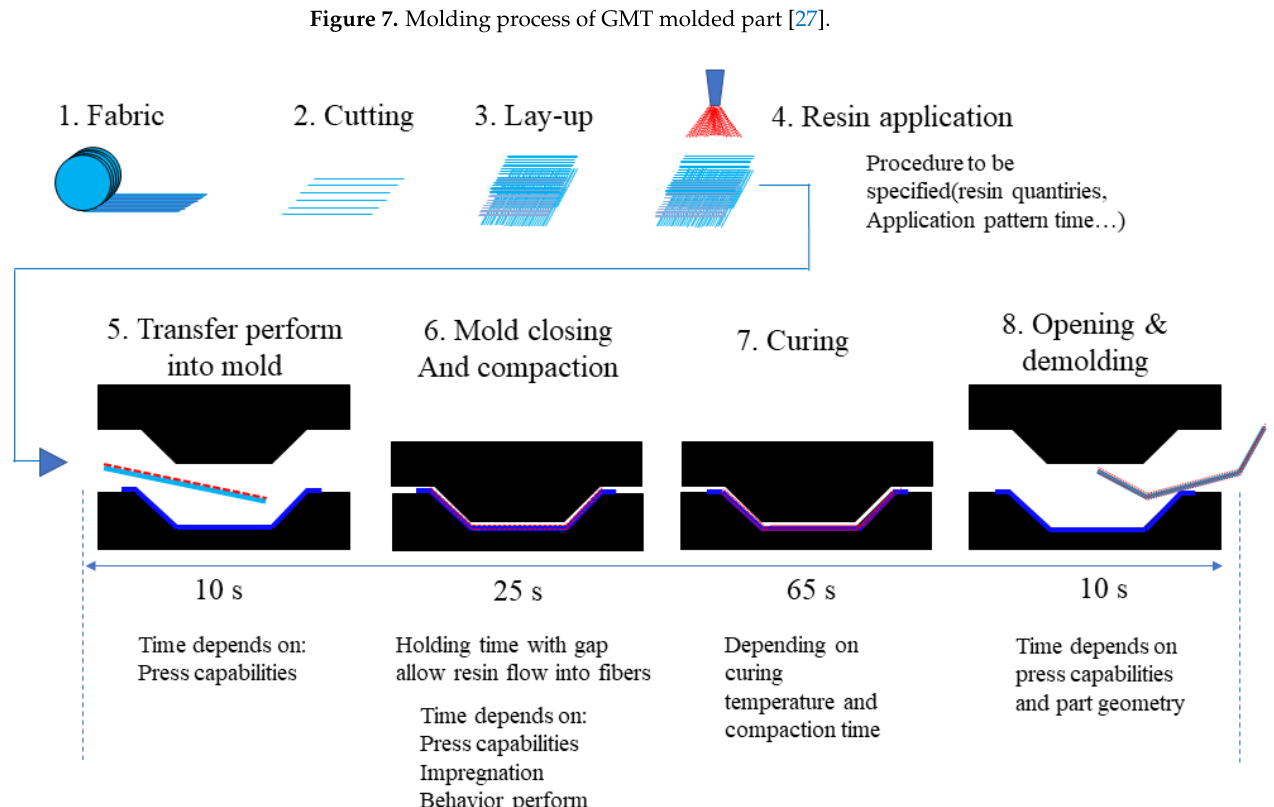
Figure 8. Wet molding process (MOMENTIVE, USA) [27]. Ren et al. [28] took WCM to utilize a carbon fiber composite bumper and confirmed the performance by conducting a frontal crash test (40%). The conclusions of the compar- ison test with the function of the steel bumper beam show the peak intrusion amount is 16.8% below that made of steel, yet the energy absorption is 57% superior. Liu et al. [29] used a lightweight CFRP header rail fabricated by WCM to conduct drop-weight impact tests. Then, they compared the failure modes, force responses, energy absorption charac- teristics, and structural responses to different directional loads. The experiment results